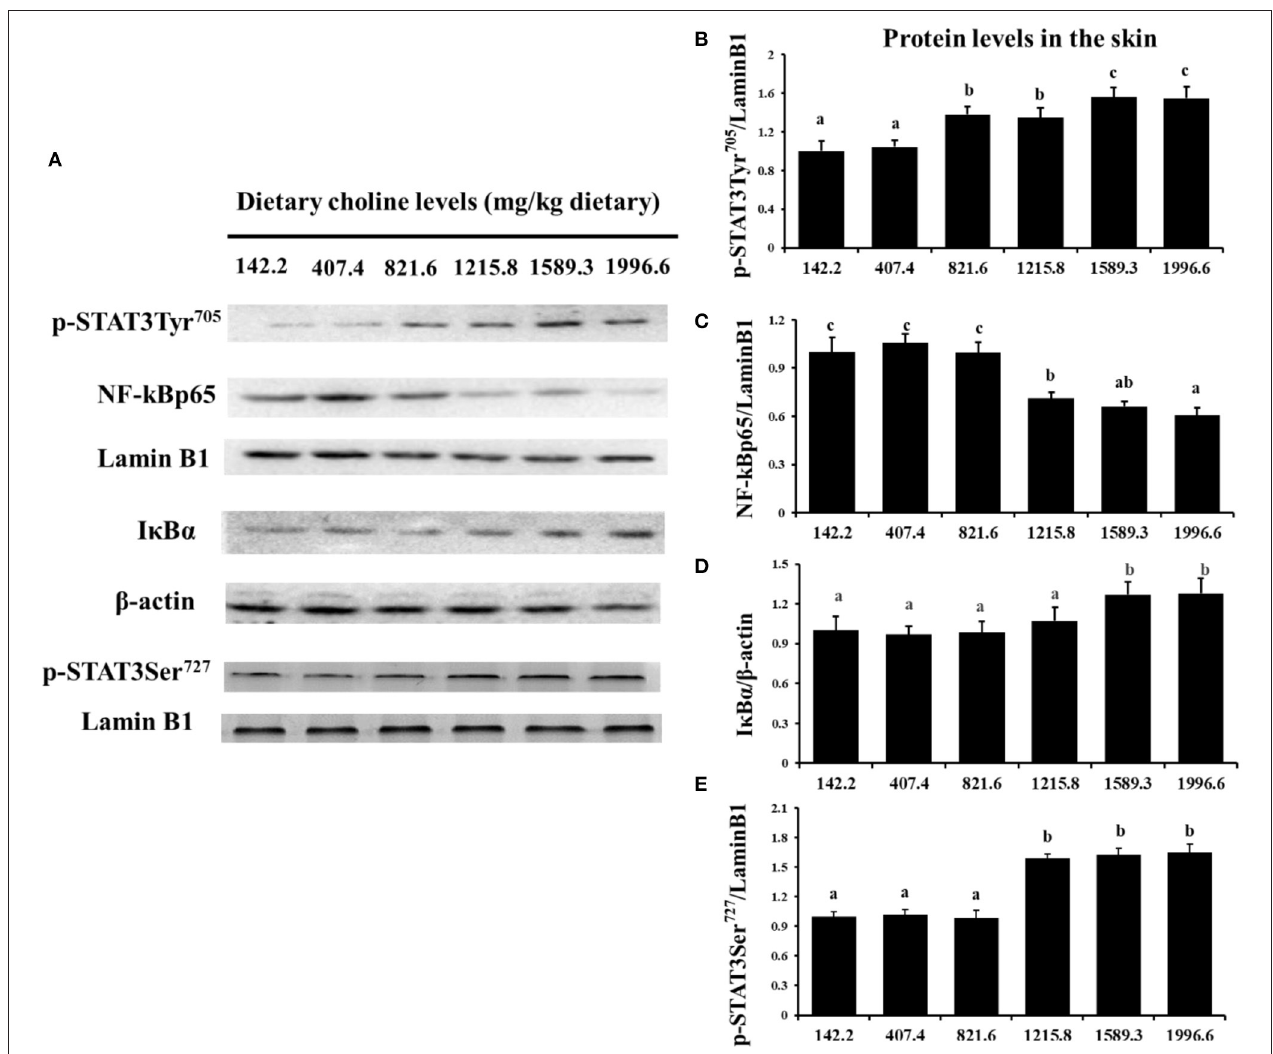
FIGURE 6 | Western blot analysis of p-STAT3Tyr705, p-STAT3 Ser727, NF- κ Bp65, and I κ B α protein level in the skin of juvenile grass carp fed diet containing different levels of choline after infection with A. hydrophila . Values are means (six replicates per group), and standard error represented by vertical bars. a,b,c Mean values with unlike letters were significantly different between treatments ( P < 0.05). (A) Protein bands of p-STAT3 Tyr705, NF- κ Bp65, and I κ B α . (B) The relative protein expression of p-STAT3 Tyr705/laminB1. (C) The relative protein expression of NF-Kp65/laminB1. (D) The relative protein expression of I κ B α /laminB1. (E) The relative protein expression of p-STAT3